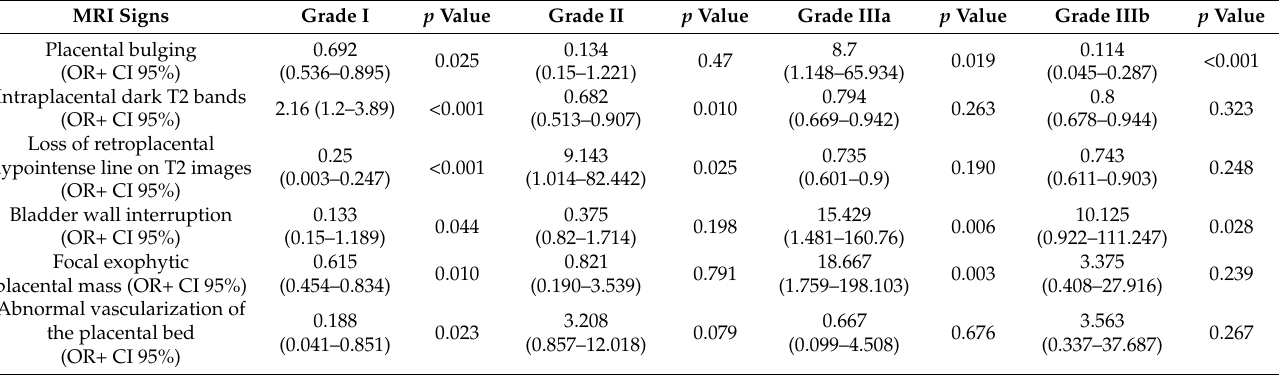
Table 6. Multivariate logistic regression for the association between MRI signs and FIGO grading of PAS